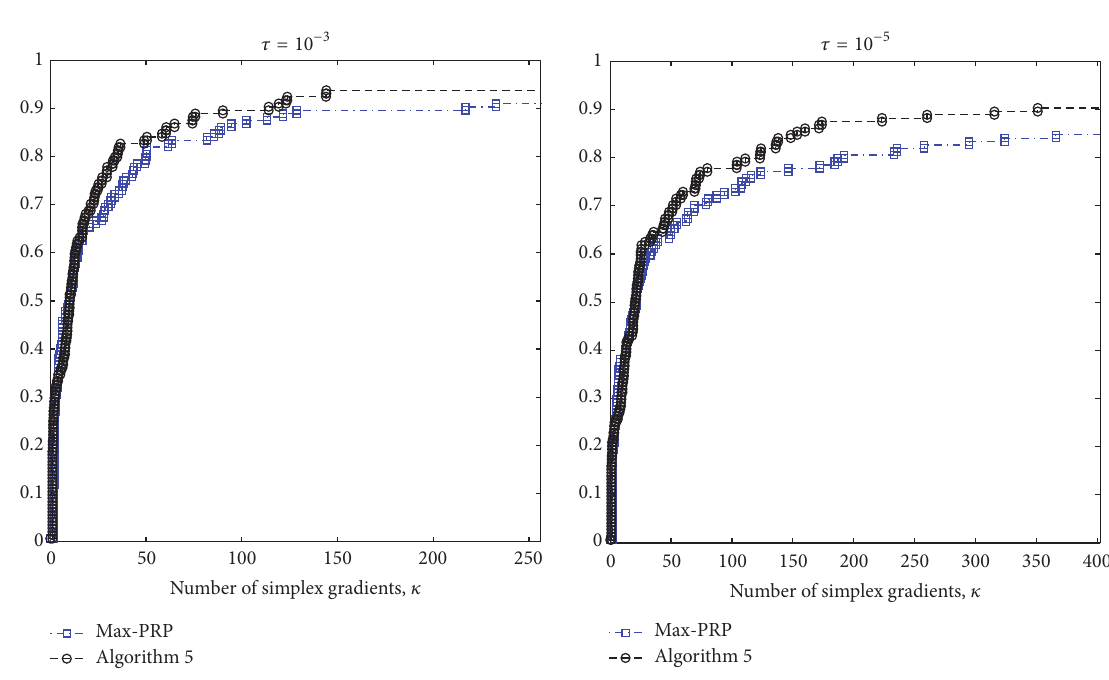
Figure 2: Data profiles 𝑑 𝑠 (𝜅) for problems 𝑃